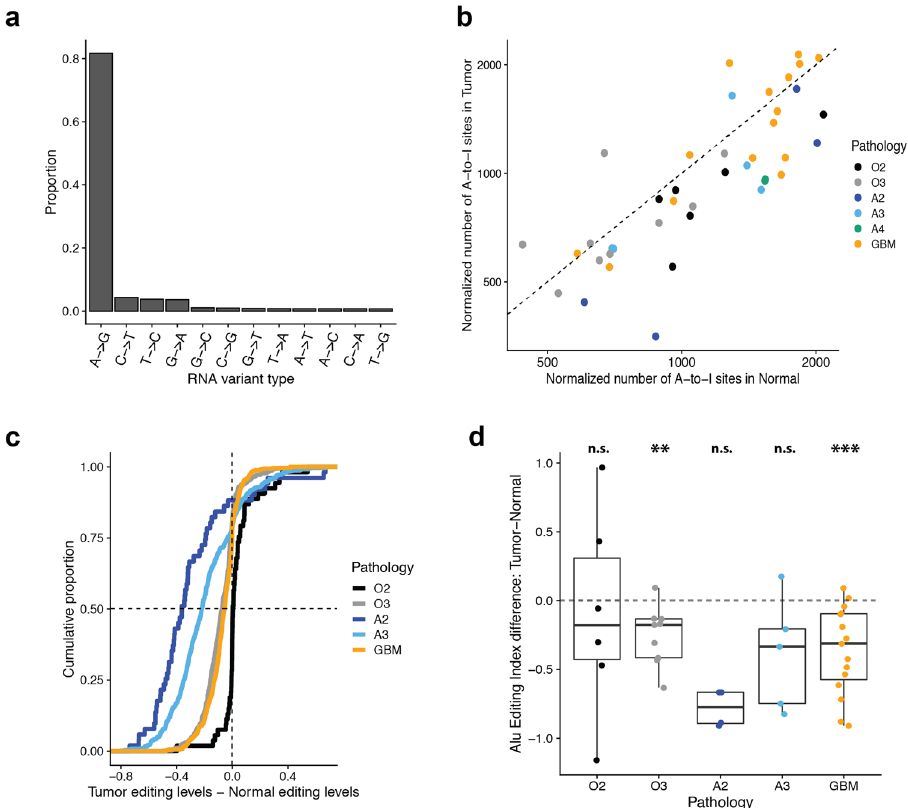
Fig. 1 RNA-editing sites and A-to-I editing levels in glioma. a Our unbiased computational pipeline detects RNA variants in 82 samples from patients of brain tumors. A-to-G type is most abundant among the identi fi ed RNA variants, indicating that most RNA variants are A-to-I editing sites. b Numbers of A-to-I editing sites per one million reads were plotted for individual patients (dots) of different pathologies (colors) according to tumor and normal tissues (y- and x-axis values, respectively): grade 2 oligodendroglioma IDH mutant and 1p/19q-codeleted (O2), grade 3 oligodendroglioma IDH mutant and 1p/19q-codeleted (O3), grade 2 IDH mutant astrocytoma (A2), grade 3 IDH mutant astrocytoma (A3), grade 4 IDH mutant astrocytoma (A4), and glioblastoma (GBM). The dashed line indicates the line of y = x. c Distributions of A-to-I editing level changes in tumors relative to matched normal tissues were described in a cumulative way for different pathologies: the shift of the curve to the left to 0 means overall decrease in tumor relative to normal tissues. d Distributions of Alu Editing Index (AEI) differences per pathology: each dot is a patient ( N = 6, 9, 4, 5, 15 patients for O2, O3, A2, A3, GBM, respectively). The p values testing whether means are different from 0 by Wilcoxon text (paired), were shown (**: p value < 0.01, ***: p value < 0.001, ns not signi fi cant, p value > 0.05). In a boxplot, the whiskers extend from the bottom and top of the box (the fi rst and third quartiles) to the largest and the smallest value no further than 1.5 * interquartile